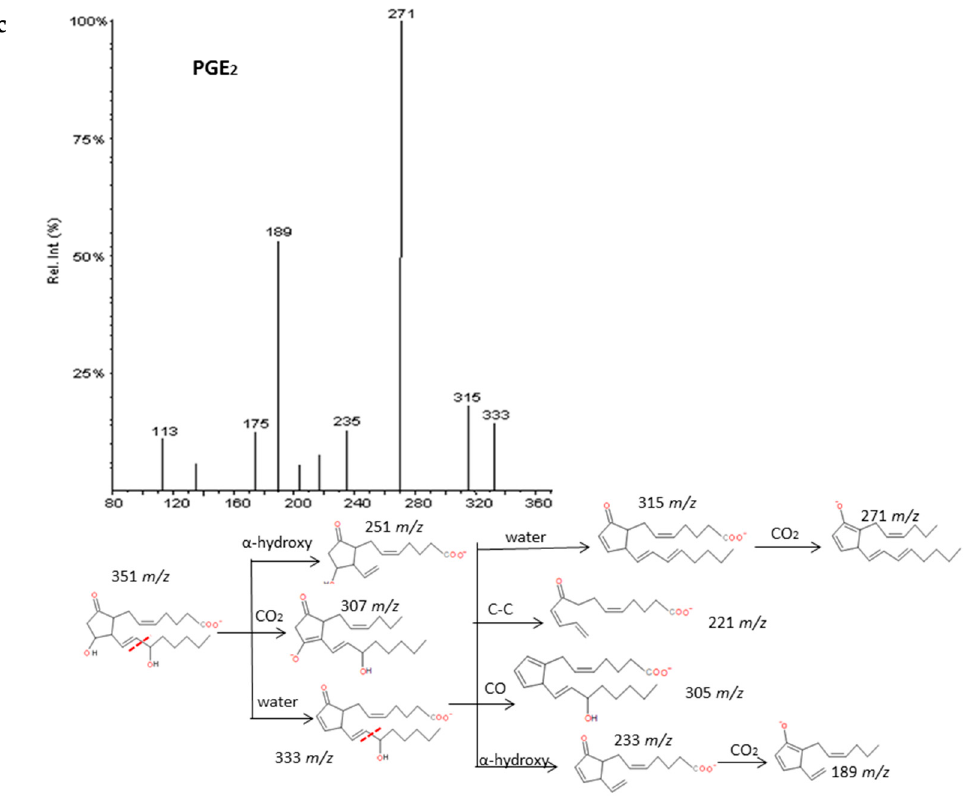
Figure 4. Fragmentation patterns suggested for ( a ) PGE 3 , PGD 3 , ( b ) PGF 2 α . and ( c ) PGE 2 . Product ion spectra at m/z 349, m/z 353, and m/z 351 were obtained from the LIPID MAPS database at CID 30V. An identical spectrum was found for PGE 3 and PGD 3.